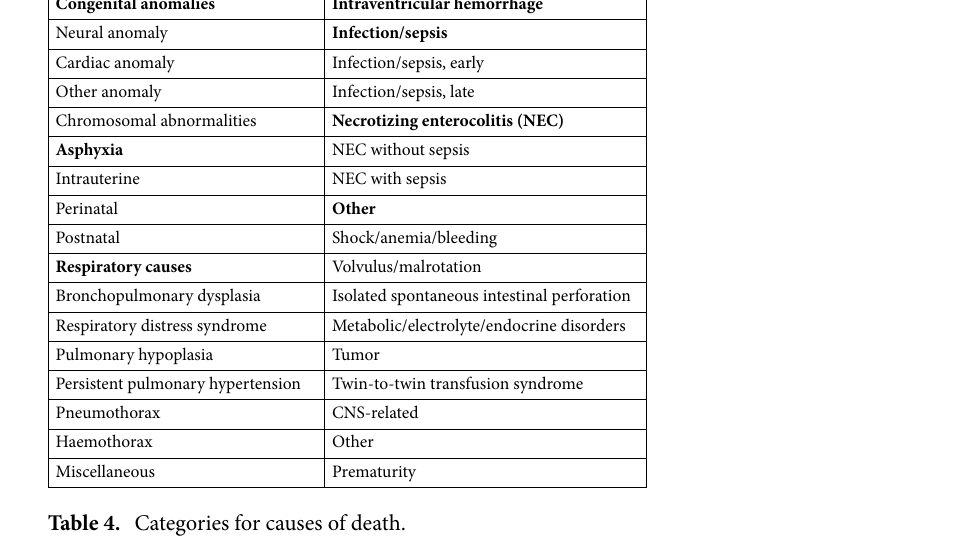
Table 4. Categories for causes of